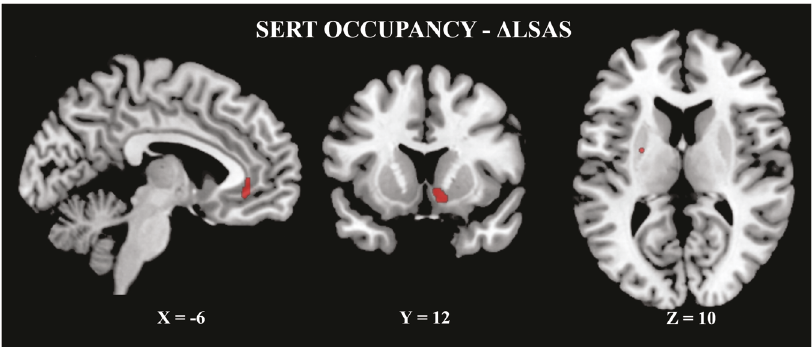
Fig. 2 PET results from the SSRI + ICBT group. Regions where signi fi cant positive associations between SERT occupancy and symptom improvement were detected, i.e., the left anterior cingulate, right nucleus accumbens and left putamen.